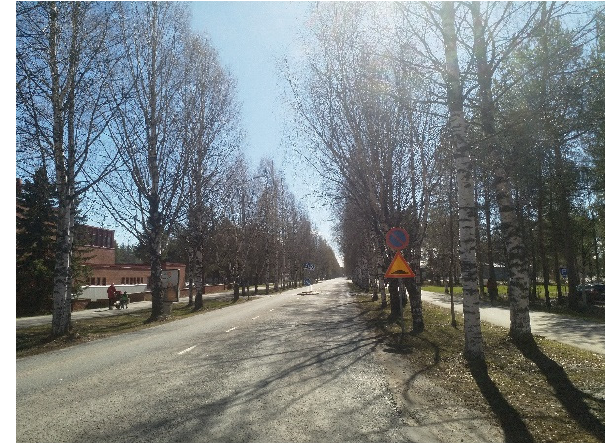
Figure 13. Conditions in spring (location 1).